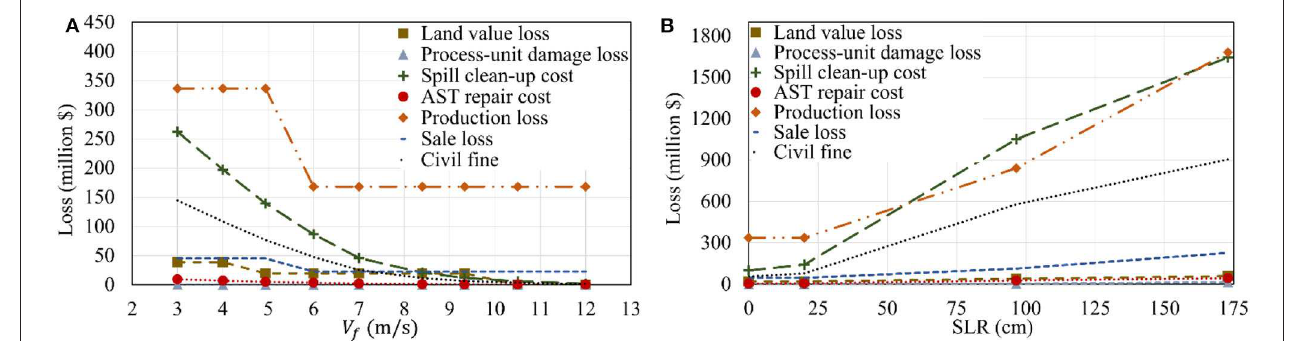
FIGURE 10 | Effect of (A) the forward speed and (B) SLR of FEMA 33 on the loss components at Refinery 7.